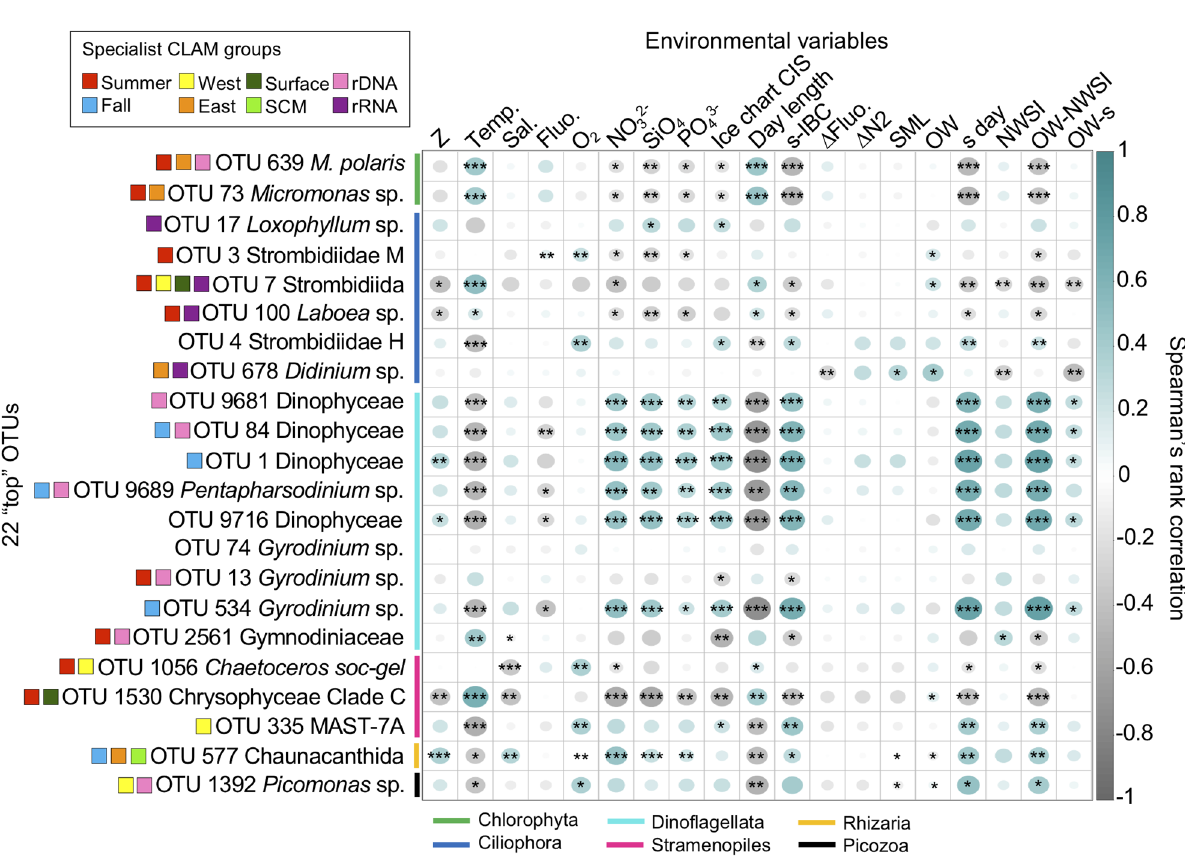
Figure 7. Spearman’s rank correlation ( ρ ) matrices between environmental variables and the 22 top OTUs (reads > 0.5% of the entire community) from both rDNA and rRNA reads. Spearman correlation coefficient values are represented by the size of the circles (larger for high coefficients; smaller for low coefficients) and color (blue – positive; grey – negative), empty squares indicate no correlation. Asterisks within circles represent the significance level p -value from Spearman’s Rho ( p < 0.05 *, p < 0.01 **, p < 0.001 ***) . Environmental variables: depth of sampling (Z), water temperature (Temp.), salinity (Sal.), Chl a fluorescence (Fluo.), dissolved oxygen (O 2 ), nitrate (NO 3 2− ), silicate (SiO 4 ), phosphate (PO 4 3− ). Also given are values from the visual analysis of ice charts produced by the Canadian Ice Service (CIS): day-length (from Fig. 2); days between sampling (s) date and ice bridge collapsing (s-IBC); depth of maximum mean vertical gradient in fluorescence, dFluo./dz (ΔFluo.); pycnocline is the depth of Brunt-Väisälä frequency maximum (ΔN 2 ); depth of the Surface Mixed Layer (SML); day of the year of when the polynya opened as open water (OW); day of the year when the samples were collected (s day); day of the year when new winter sea ice (NWSI) occurred; total days between OW and NWSI (OW-NWSI); days from the beginning of OW to sampling